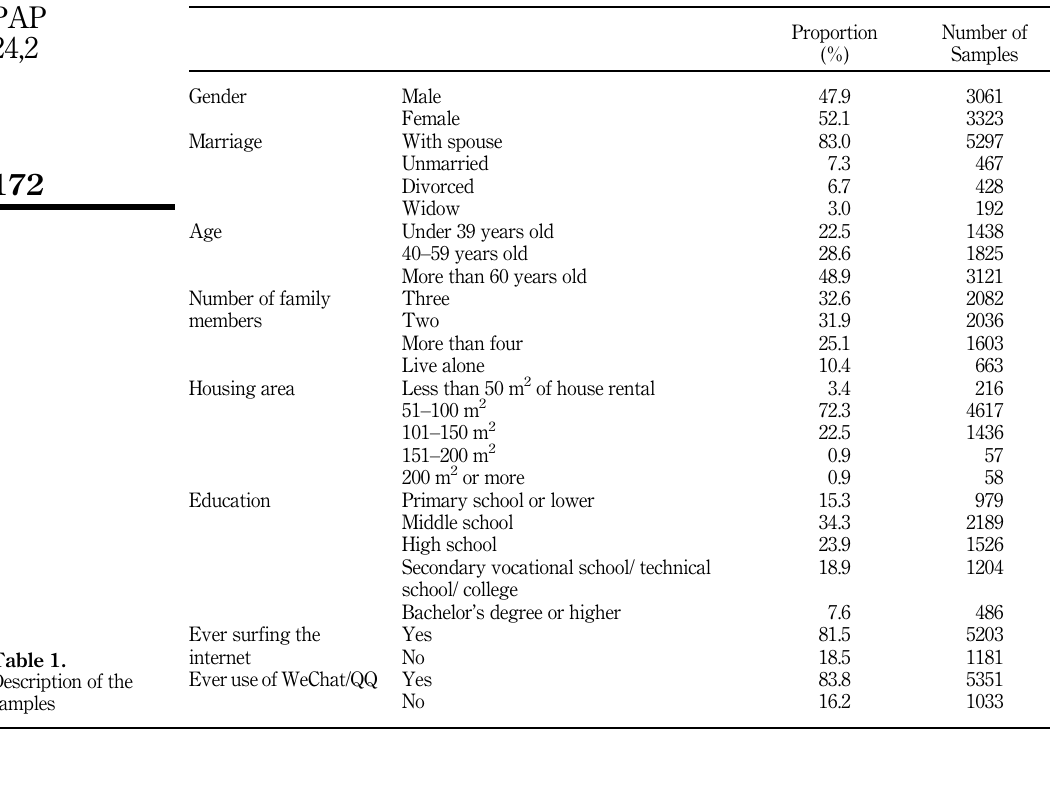
Table 1. Description of the